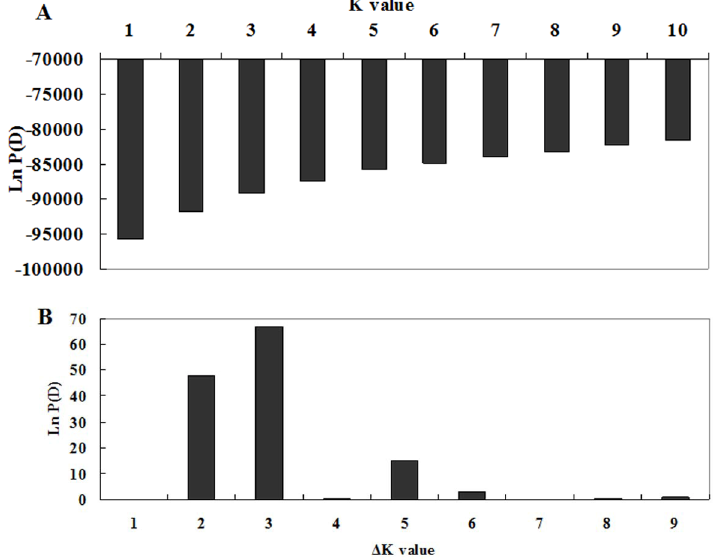
Fig 2. Calculation of true K of tall fescue accessions and (A) Evolution of the average logarithm probability of the data likelihoods (LnP(D)) for tall fescue genotypes; (B) Magnitude of Δ k for each K value according to Evanno et al . [38].